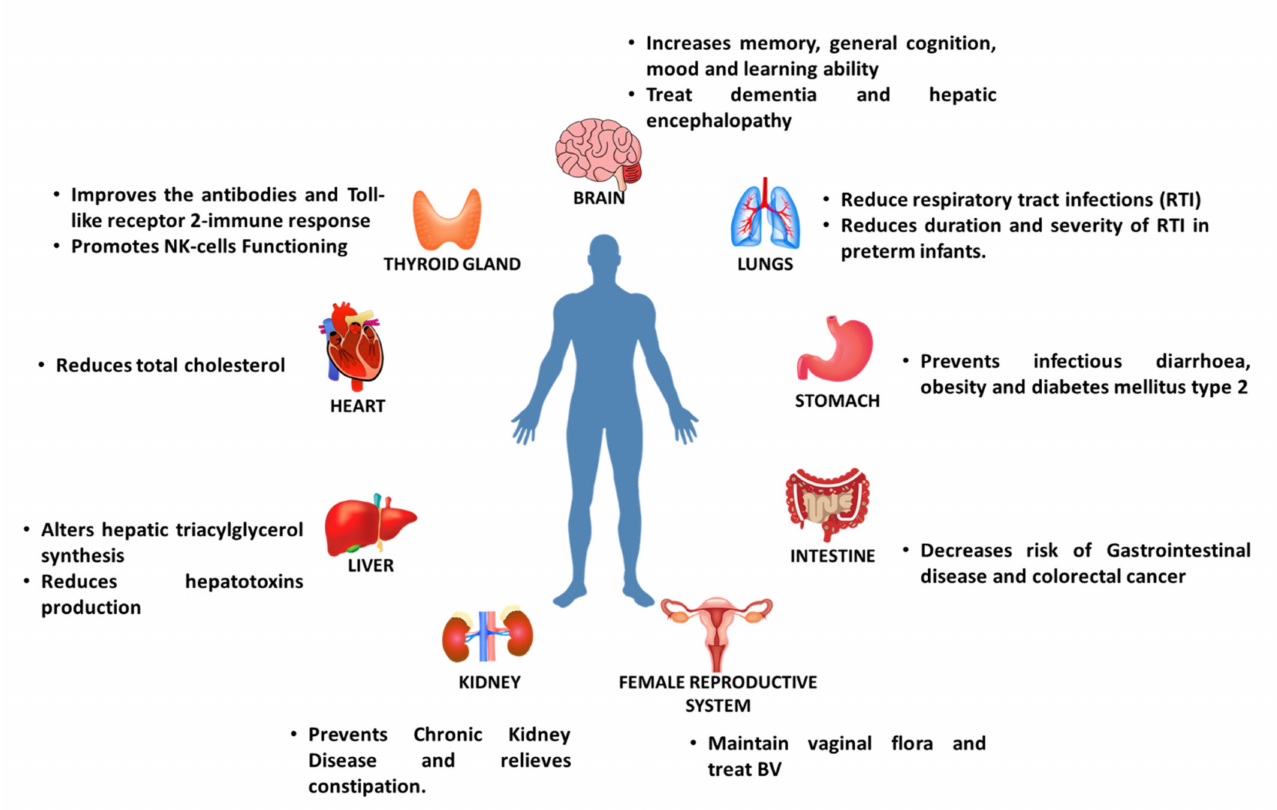
Figure 2. Effects of prebiotics on different organs in